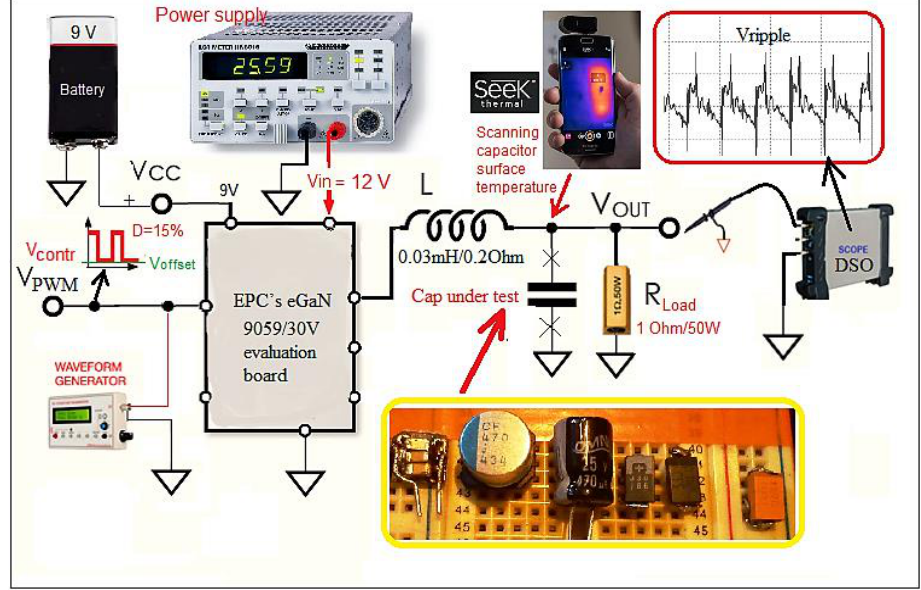
Figure 5. Diagram of connections used to obtain the voltage ripple waveforms and capacitor’s temperature. The actual tested capacitors shown are: MLCC, polymer electrolytic, aluminum electrolytic, Ta-polymer, multilayer polymer, MnO 2 -tantalum technologies.